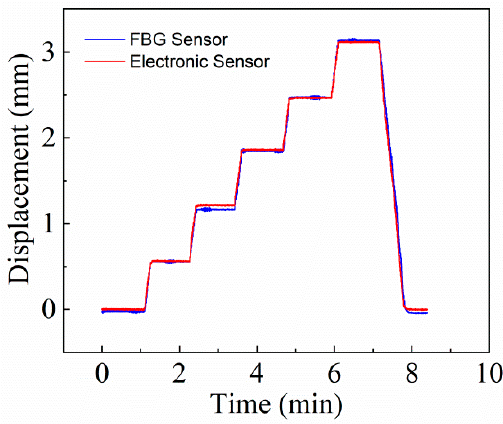
Figure 12. Comparison results of FBG sensor and electronic sensor.